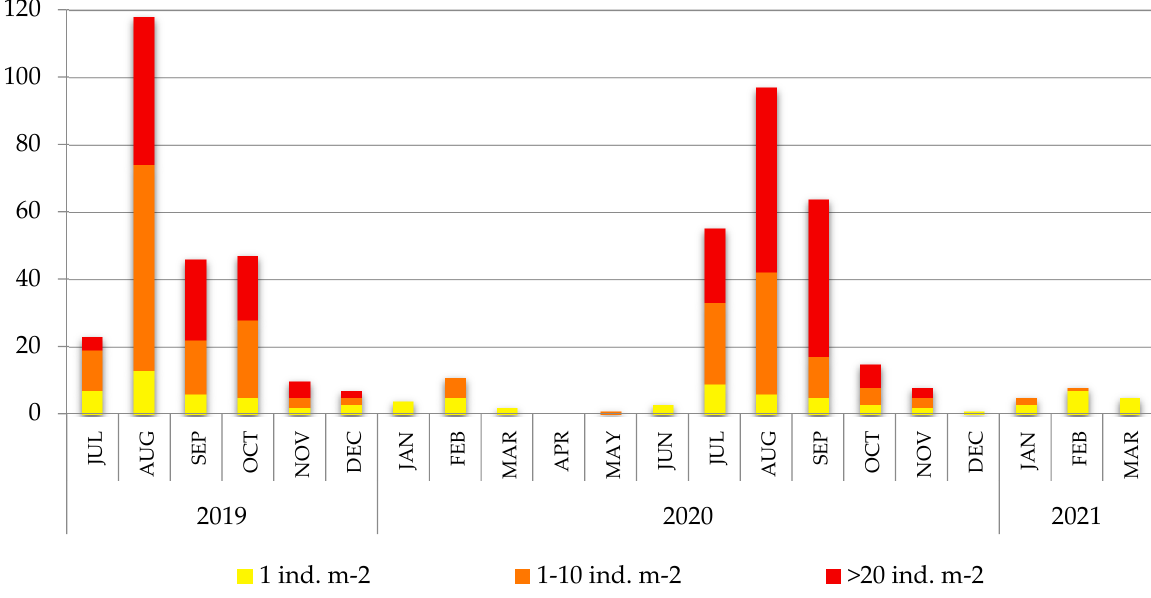
Figure 7. Number of sightings per month of M. leidyi and reported abundance range (yellow: 1 ind. m − 2 ; orange: 1–10 ind. m − 2 ; red: >20 ind. m − 2 ). Table 2. Number of sightings collected for each signaled taxon. Sightings are separated per year and per reported abun- dance range.